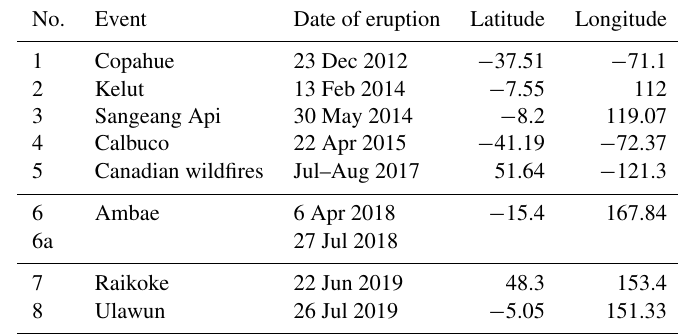
Table 1. Volcanic eruptions and biomass burning events shown in Fig. 3.